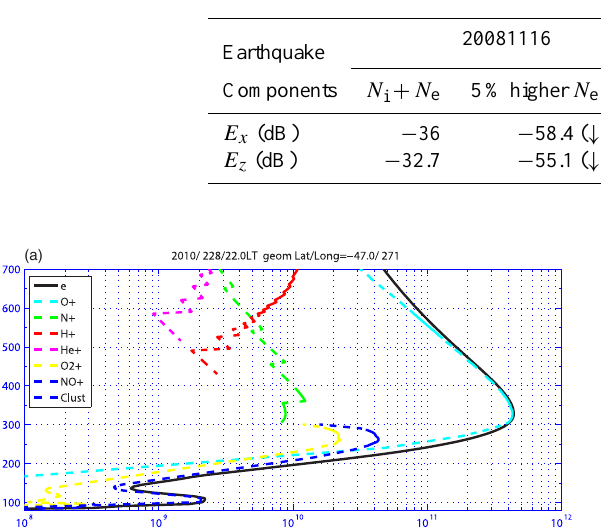
Table 4. Simulation result of E x and E z (660km) at 1Hz during earthquake and before earthquakes.